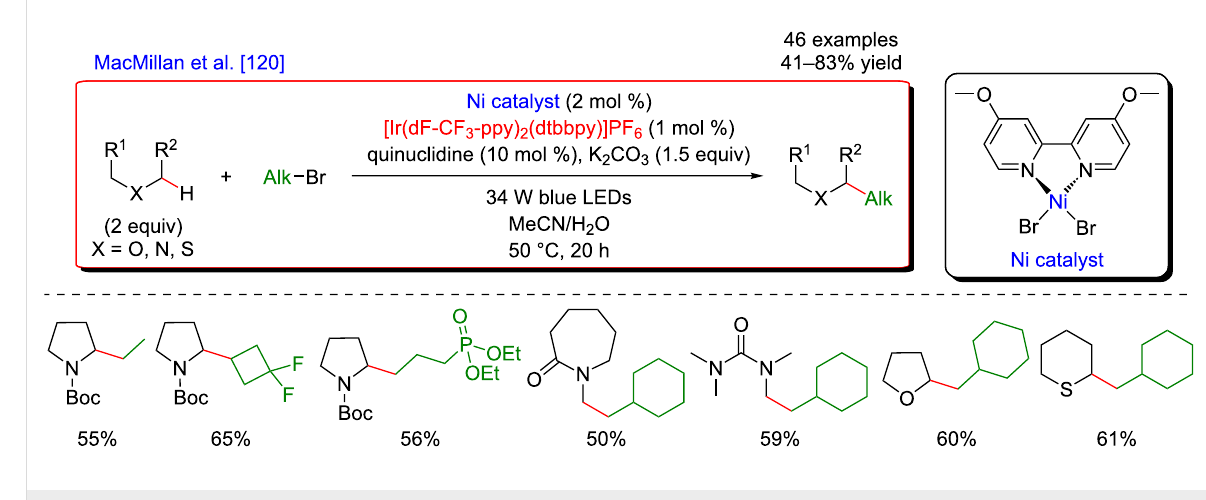
Figure 64: Selective sp 3 –sp 3 cross-coupling promoted by H-atom transfer.